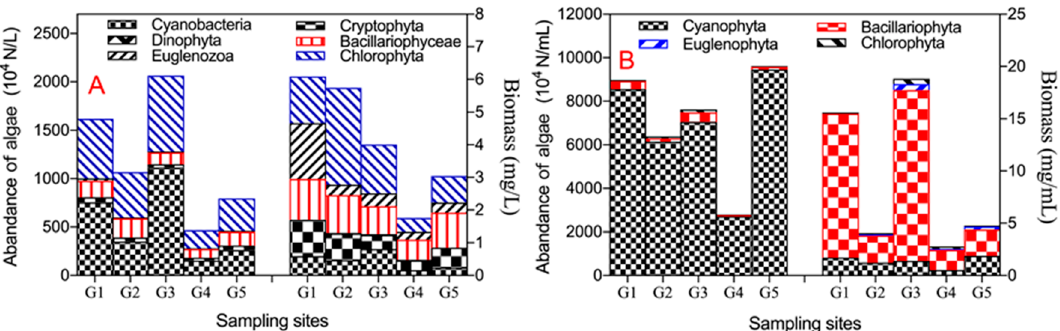
Figure 3. The spatial distribution characteristics of abundance and biomass of planktic ( A ) and epipelic ( B ) algae. Notes: the left bars are the abundance of planktic algae expressed with the left axis, and the right bars are the biomass of planktic algae expressed with the right axis.